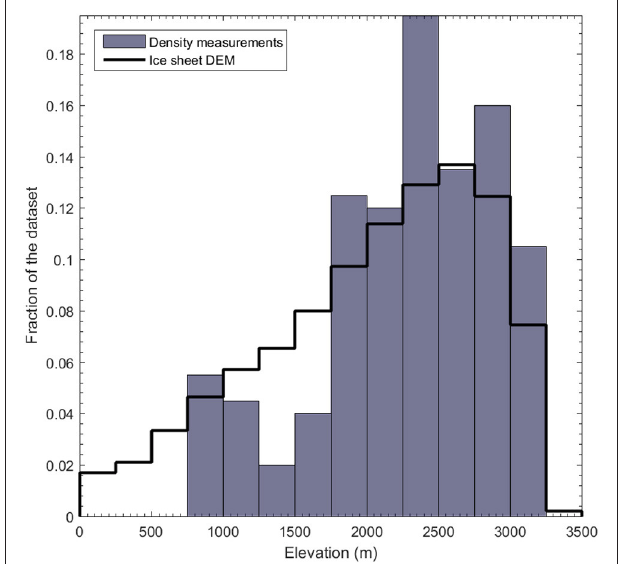
FIGURE 5 | Elevation distribution of the surface snow density measurement locations compared to the area-elevation distribution of the entire Greenland ice